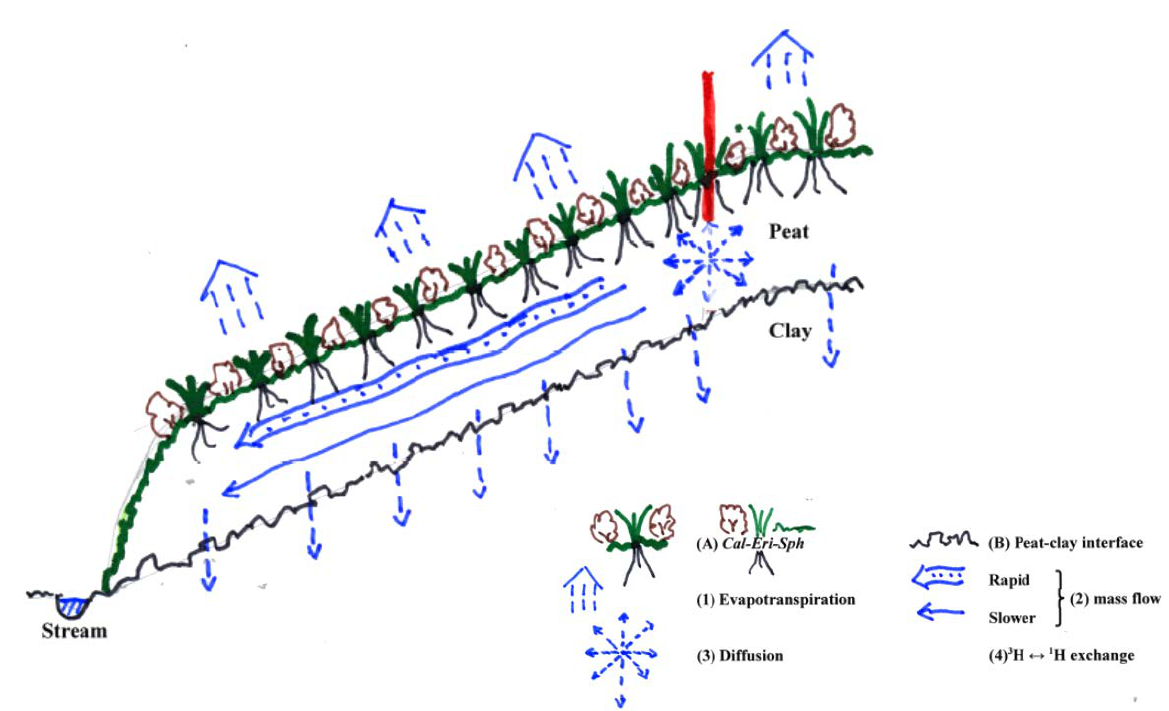
Figure 13. Cartoon of structures (A, B) and processes (1 to 4) of tritium movement. (A) Cal-Eri-Sph = Calluna vulgaris, Eriophorum vaginatum, Sphagnum spp. surface vegetation. (B) Interface between peat and sandstone fragments of many sizes embedded in tenacious clay. (1) Evapotranspiration of tritium- containing water transported through the roots and leaves of rooted plants, and around the leaves and stems of Sphagnum ; (2) mass (bulk) mainly lateral flow of tritium- containing water, more rapidly nearer the surface; (3) diffusion, shown near the injection site and into the clay, but actually operating everywhere; (4) 3 H ↔ 1 H exchange, not shown specifically but operating